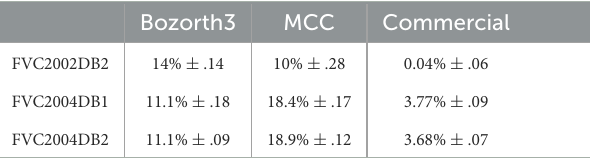
TABLE 1 AUC values for the three datasets with Bozorth, MCC, and the commercial matching algorithms.